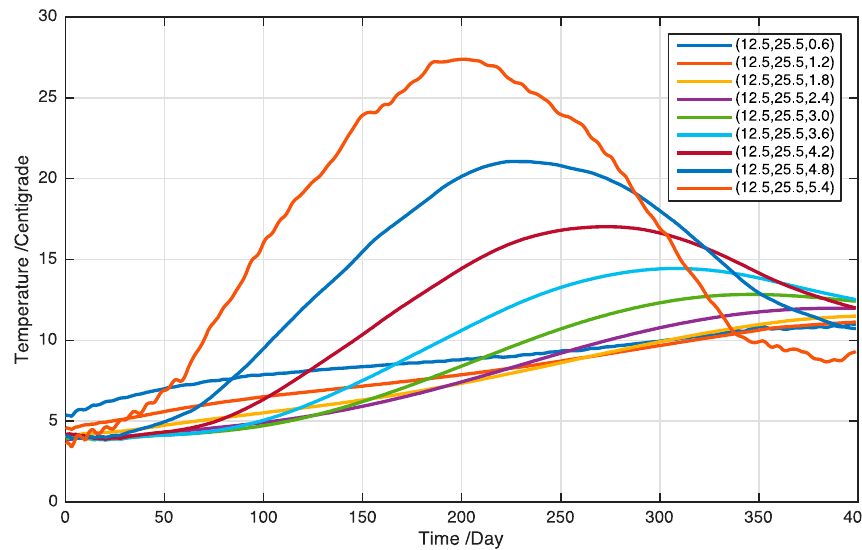
Figure 8. Examples of temperature profiles at different locations.